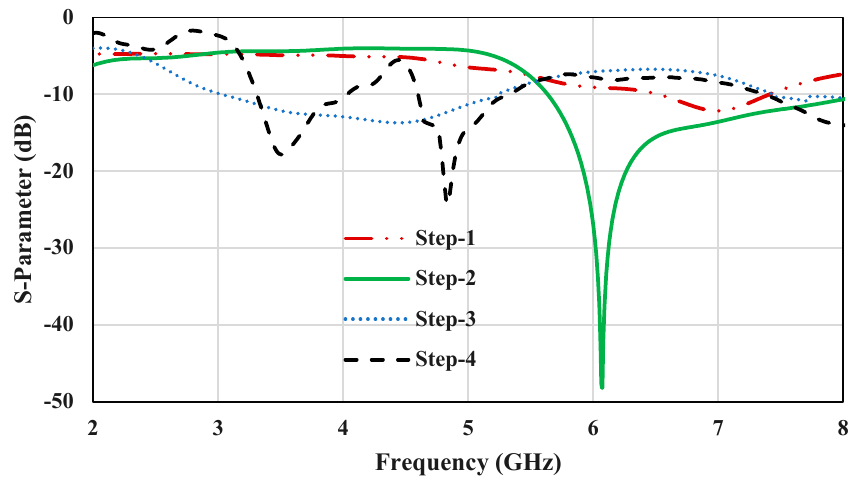
Figure 4. Simulated S − Parameter characteristics for the antennas shown in Figure 1.